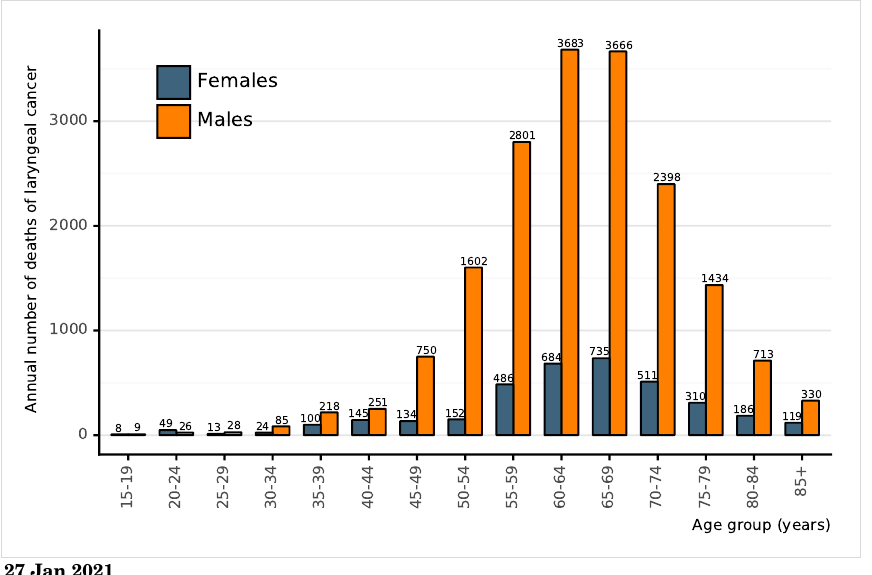
Figure 51: Annual number of deaths of of laryngeal cancer in India (estimates for